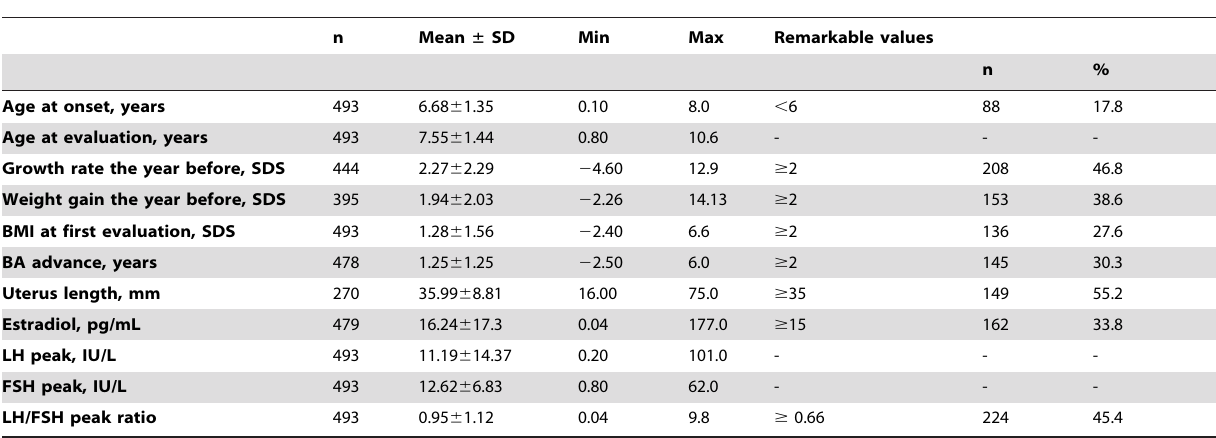
Table 1. Characteristics of 493 girls with idiopathic CPP.